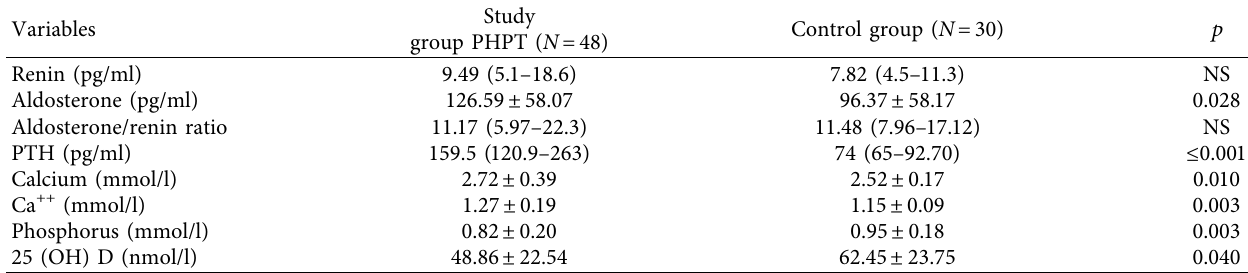
Table 2: Diferences in biochemical parameters between the study and control group.